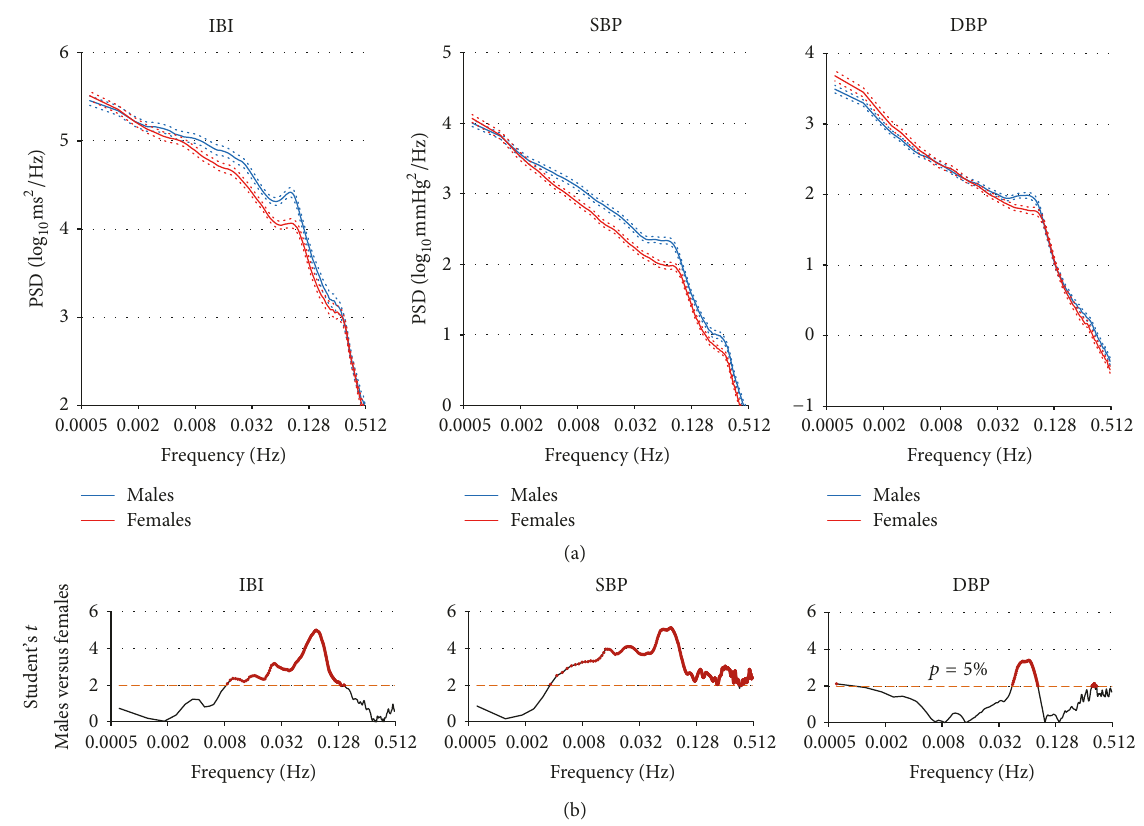
Figure 9: Power spectra of IBI, SBP, and DBP: comparison by sex . (a) Mean ± standard error of the mean; (b) Student’s 𝑡 statistics at each frequency for comparing males ( 𝑁 = 42 ) versus females ( 𝑁 = 42 ). Dashed horizontal lines represent the 5% significance threshold; 𝑡 values above the threshold (red dots) indicate differences significant at 𝑝 < 5 %.